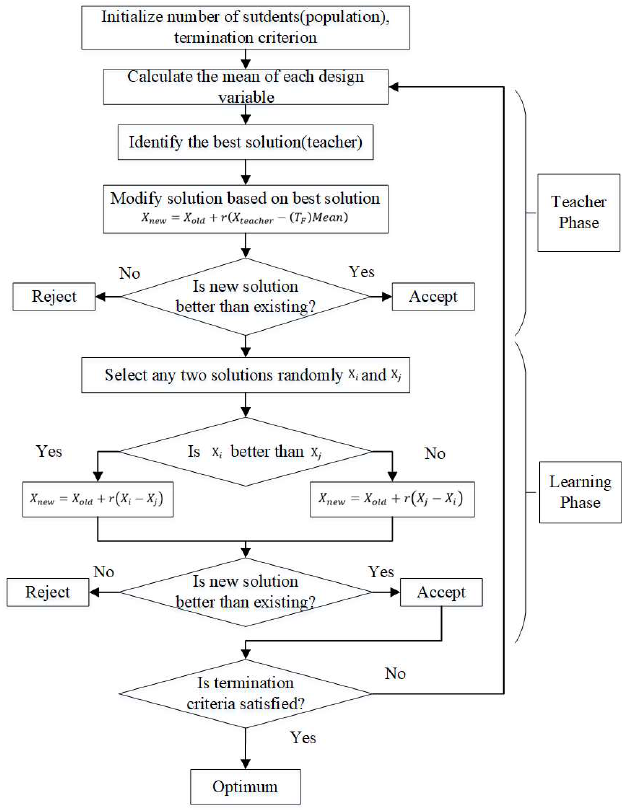
Figure A8. The framework of the TLBO algorithm.